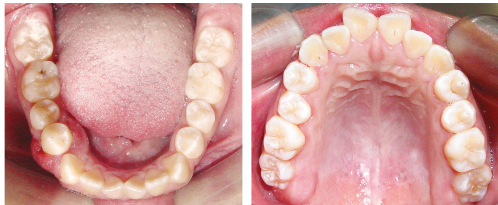
Figure 1: Adequate oral hygiene aspect.